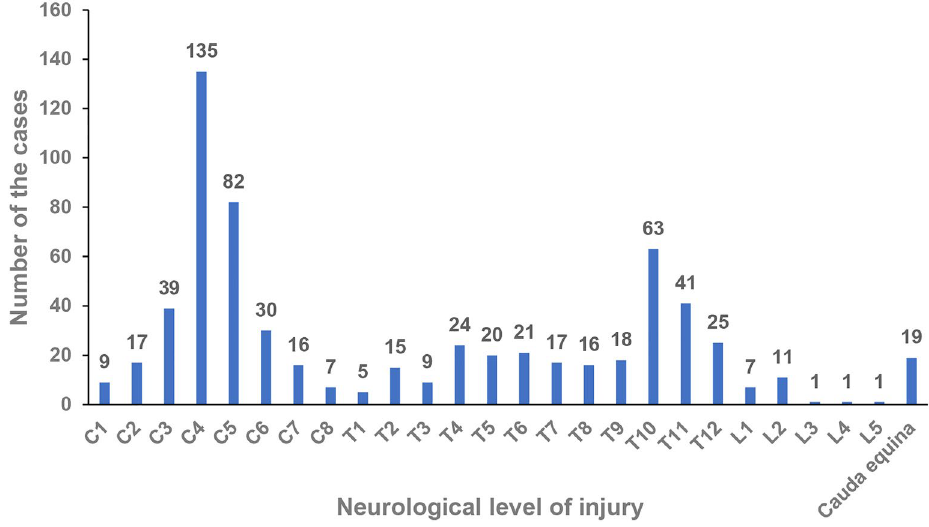
Figure 2. Distribution of TSCI level in all 649